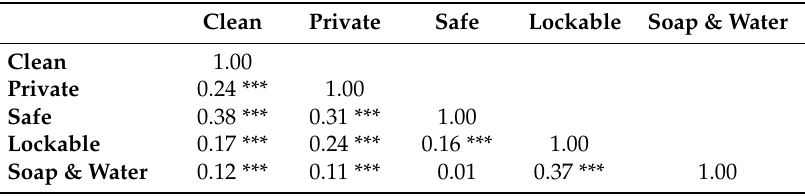
Table 3. Interrelationships between women’s ratings of the characteristics of their menstrual management